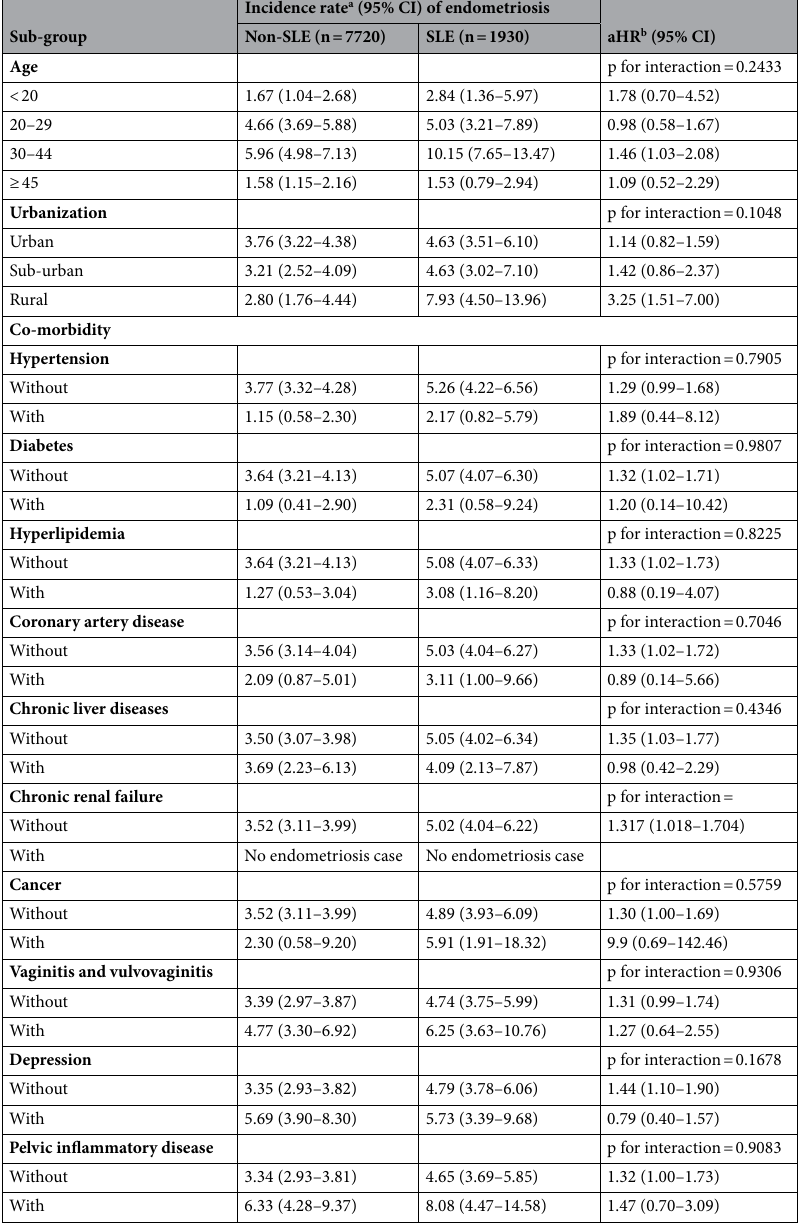
Table 3. Stratified analysis of endometriosis risk between SLE and non-SLE groups before propensity score matching. a Per 10,000 person-months. b Adjusted for baseline demographic variables, length of hospital stay, and